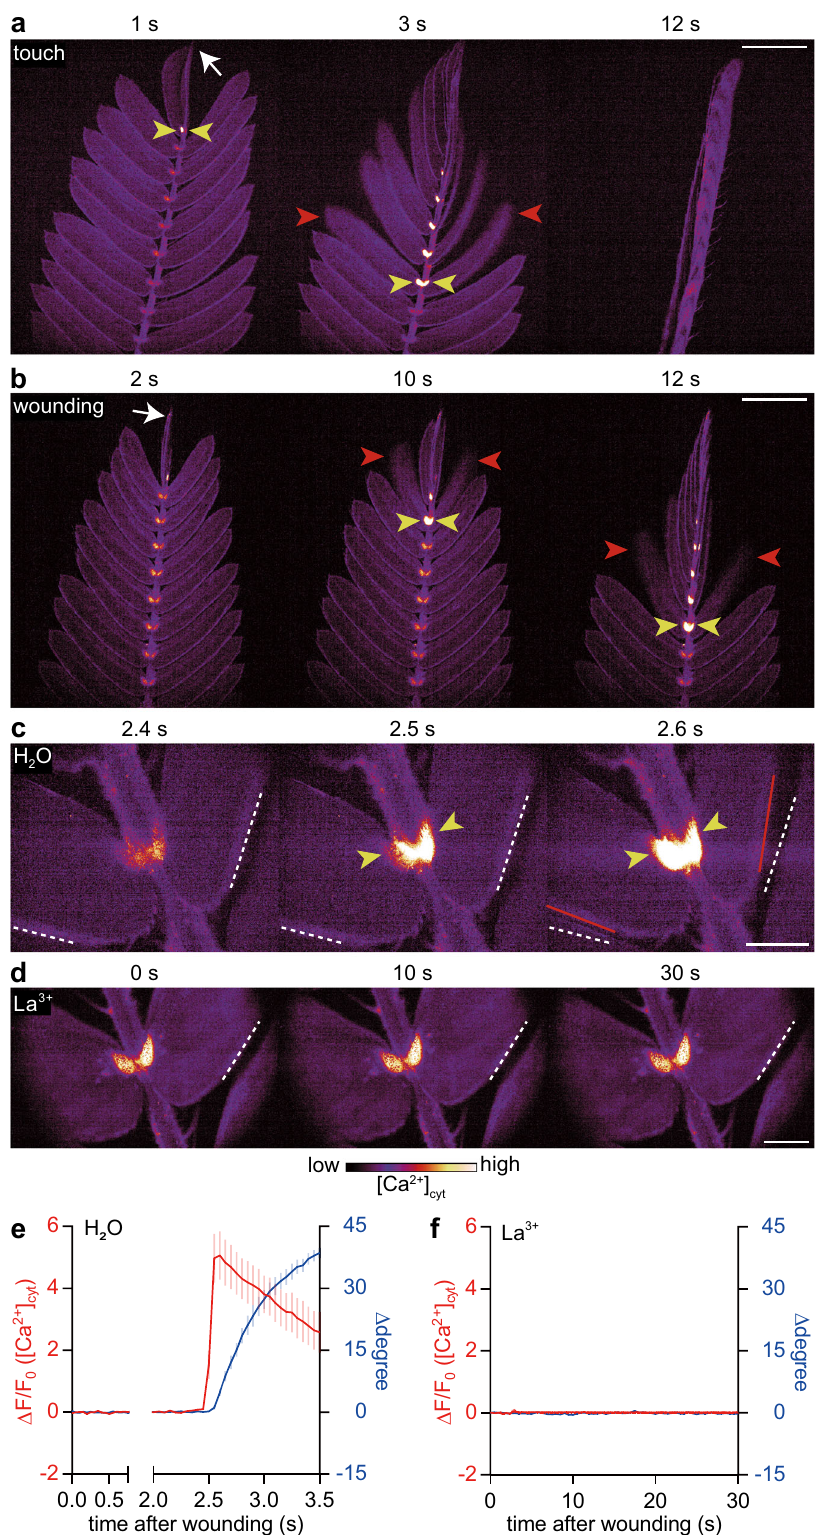
Fig. 1 | [Ca 2+ ] cyt increase at the pulvinus triggers rapid lea fl et movement. a , b Touch ( a ) and wounding ( b ) (white arrows) caused [Ca 2+ ] cyt increases at the tertiary pulvini (yellow arrowheads) and lea fl et movements (red arrowheads) that propagated toward the base of the rachilla. c , d Wounding triggered [Ca 2+ ] cyt increases at the tertiary pulvini that preceded the lea fl et displacements in control